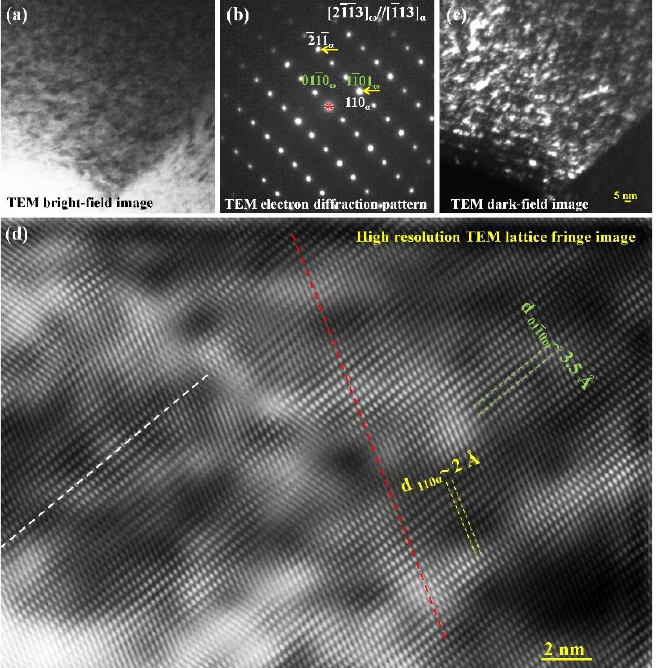
Figure 4. ( a ) TEM bright field image, ( b ) SAED pattern, ( c ) TEM dark field image, ( d ) high-resolution TEM image of as-quenched martensite in a cast iron sample.